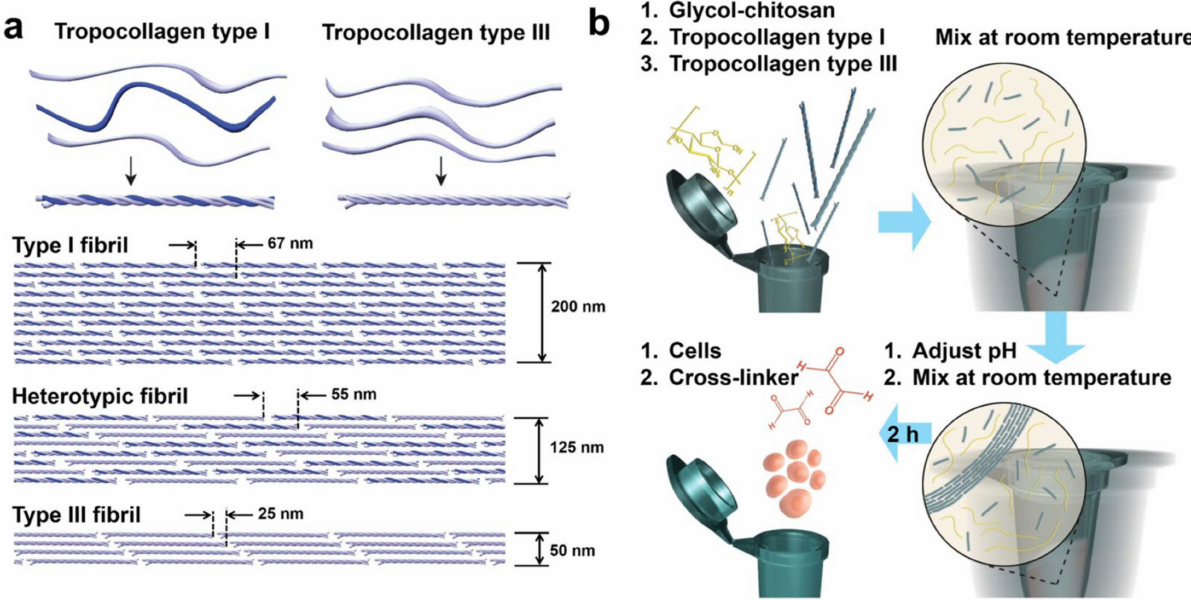
Figure 9. ( a ) Simple illustration of collagen type I and III, ( b ) Schematic representation of the step-by-step fabrication procedure of injectable hydrogel with tissue specific collagen ratio. (Reproduced with permission from [80] under creative commons CC-BY license,